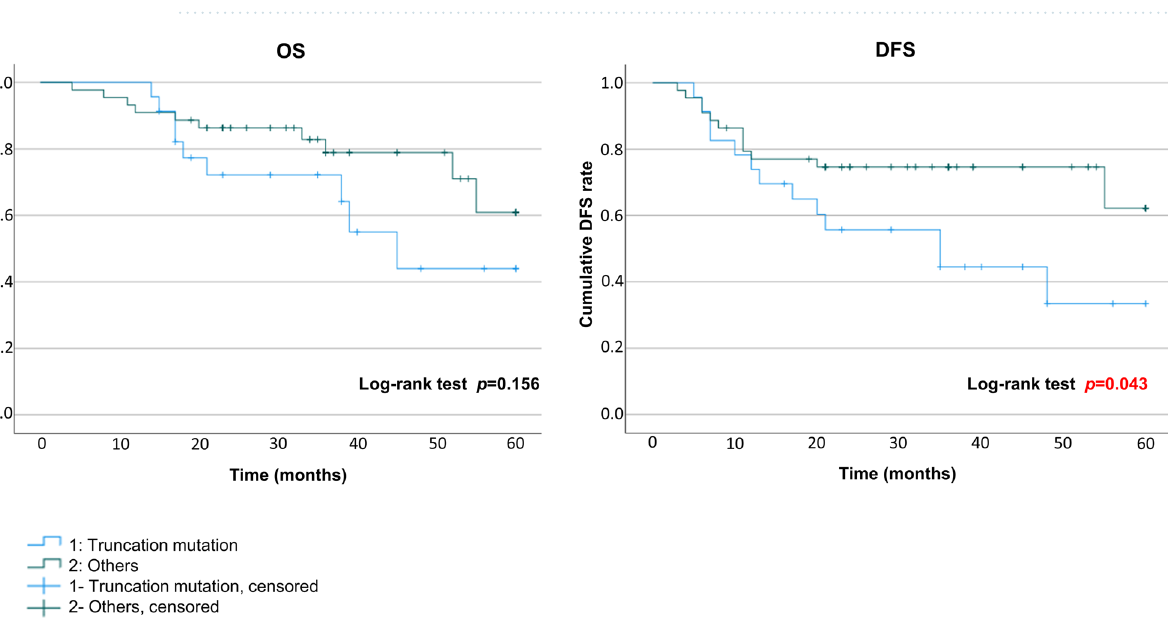
p16 + and wild-type p16− . OS and DFS were compared among the four groups using the Kaplan–Meier method with a log-rank test. There were no significant differences in OS ( p = 0.347) or DFS ( p = 0.188) among the four groups.